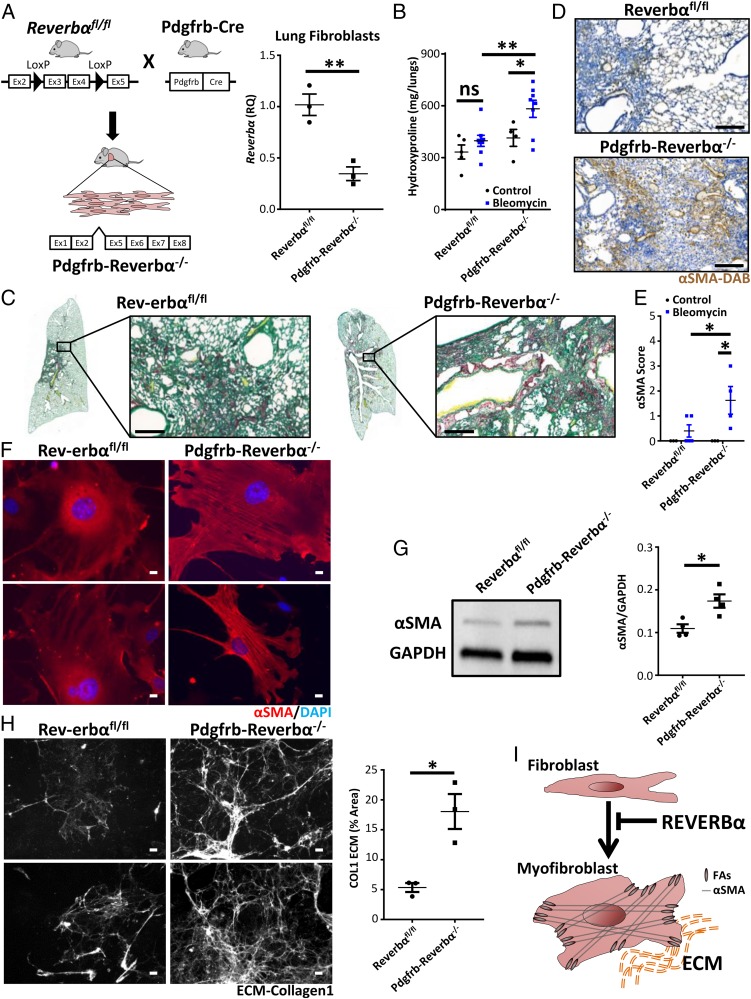
REVERBα alters susceptibility to pulmonary fibrosis through its effect on myofibroblast differentiation. (A) Schematic showing generation of Pdgfrb-Reverbα−/− mice combined with qPCR analysis of Reverbα expression in lung fibroblasts (n = 3 animals). **P < 0.01 (Student t test; mean ± SEM). (B) Hydroxyproline measurement in lungs from Pdgfrb-Reverbα−/− mice and littermate controls 28 d following challenge with intratracheal bleomycin (2 U/kg) or saline (n = 4 to 5 saline and 8 bleomycin per genotype). *P < 0.05; **P < 0.01 (2-way ANOVA Holm–Sidak post hoc test; mean ± SEM). (C) In a separate experiment, histology (Picrosirius red) of lungs was examined 28 d following challenge with intratracheal bleomycin (representative image from 4 animals treated with bleomycin per genotype). (Scale bars, 200 µm.) (D) Immunohistochemical staining of myofibroblasts (anti-αSMA, 3,3′-diaminobenzidine [DAB]) from Pdgfrb-Reverbα−/− mice and littermate controls 28 d following intratracheal bleomycin challenge (representative image from 4 animals treated with bleomycin per genotype). (Scale bars, 200 µm.) (E) Histological scoring (grade 0 to 4) for the presence of αSMA staining 28 d following intratracheal bleomycin challenge (n = 3 saline and 4 to 5 bleomycin per genotype). *P < 0.05 (2-way ANOVA Holm–Sidak post hoc test; mean ± SEM). (F and G) Representative immunofluorescence images of primary lung fibroblast cultures from Pdgfrb-Reverbα−/− mice and littermate controls showing intracellular αSMA (red) (n = 3 animals per genotype) (F) combined with a representative immunoblot and quantification of intracellular αSMA from primary lung fibroblast cultures (n = 4 animals per genotype) (G). *P < 0.05 (Student t test; mean ± SEM). DAPI, 4′,6-diamidino-2-phenylindole. (Scale bars in F, 10 µm.) (H) Representative collagen-1 ECM (extracellular matrix) images and quantification following culture of Pdgfrb-Reverbα−/− and Reverbαfl/fl primary lung fibroblasts (n = 3 animals per genotype). *P < 0.05 (Student t test; mean ± SEM). (Scale bars, 50 µm.) (I) Schematic illustrating the action of REVERBα in inhibiting fibroblast/myofibroblast differentiation. FAs, focal adhesions.